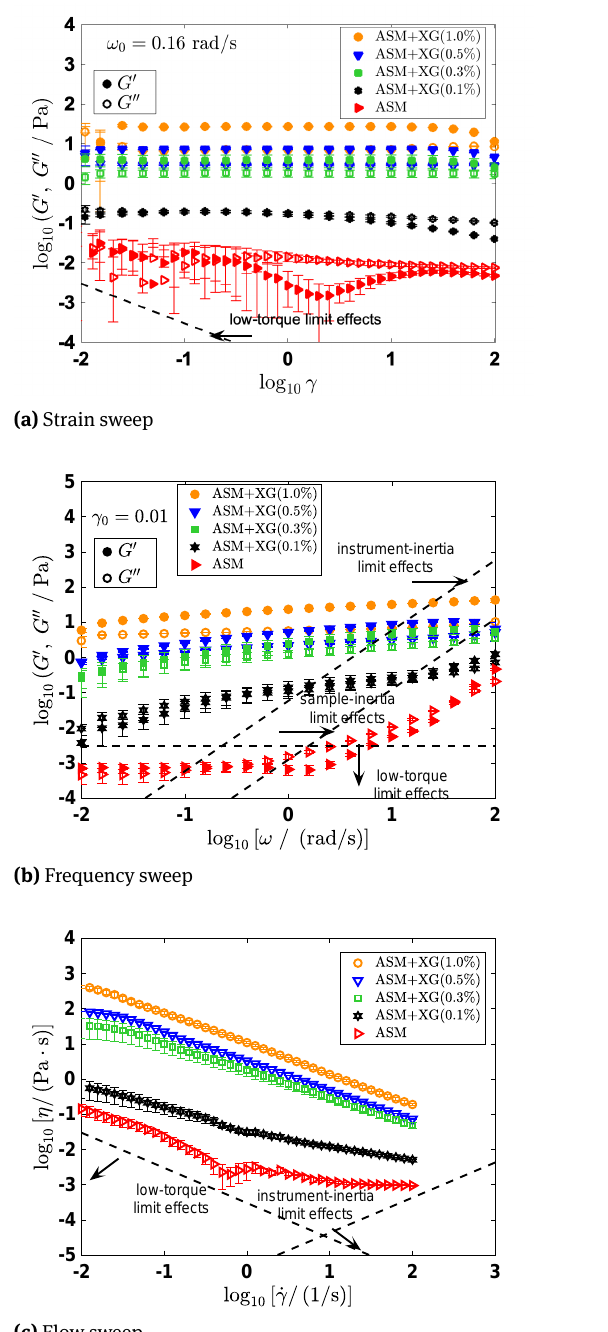
Figure 2: Rheology of ASM+XG for different concentrations of XG, C XG ∈ { 0.1, 0.3, 0.5, 1.0 } % . (a) The strain-dependent elastic mod- ulus ( G ′ , closed symbols) and viscous modulus ( G ′′ , open symbols). Strain sweeps were completed at a frequency ω 0 = 0.16rad/s . (b) The frequency-dependent elastic modulus ( G ′ , closed symbols) and viscous modulus ( G ′′ , open symbols). Frequency sweeps were com- pleted at a strain of 𝛾 0 = 0.01 . (c) The apparent shear viscosities as a function of shear rate.